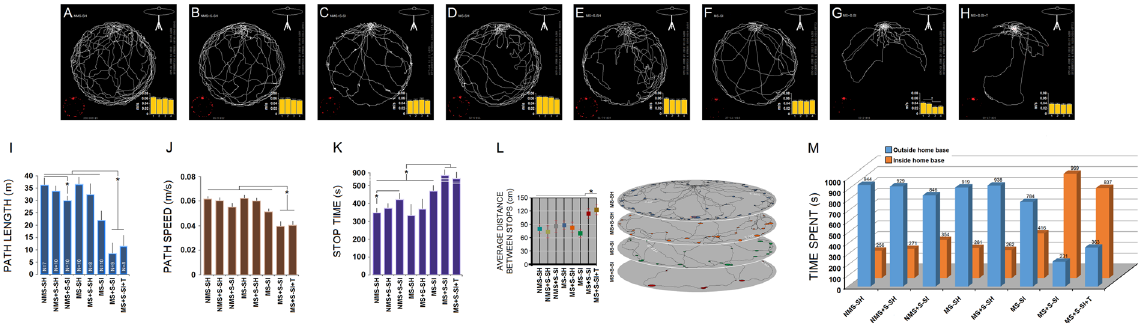
Figure 6. Combined ancestral and adulthood stress alter the profile of exploratory behaviour . ( A–H ) The paths taken by representative rats of different groups during a 20-min test session on the open field table. Note the length of path taken by MS + S-SI and MS + S-SI + T groups ( G & H ) that obviously are shorter than those by other groups. Home base was located at 12:00 O’clock on the table. (Bottom sub-panel-left; red dots) Representation of stops dispersion during exploration of the table top. (Bottom sub-panel-right) Rats’ speed during 20-min exploration assigned to four 5-minute intervals indicated that MS + S-SI and MS + S-SI + T groups were less motivated to explore the arena than other groups and made shorter path lengths ( I ) with lower speed ( J ) than other groups. Stop time ( K ) and average distance between stops ( L ) also indicated lower level of motor activity on the table in MS + S-SI rats compared to controls. Note the quadruple stack of plots that represent stops dispersion and distance between each stop during excursion. Stop duration is also represented by the bubble’s diameter. ( M ) Time spent inside or outside the home base by each group during a 20-minute session. MS + S-SI and MS + S-SI + T groups spent significantly more time inside the home base than outside, and more than any other